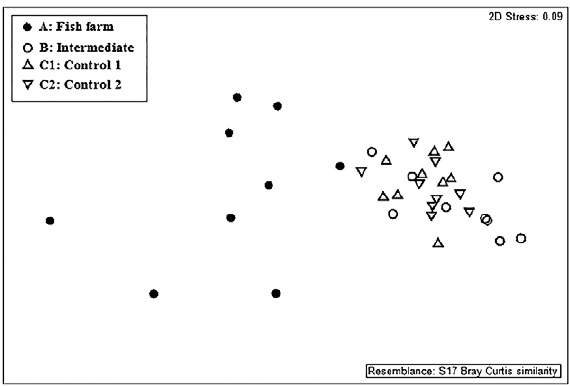
Fig. 3. – Non-metric multidimensional scaling ordination analysis on the Bray-Curtis similarity of non-transformed abundance data of polychaete